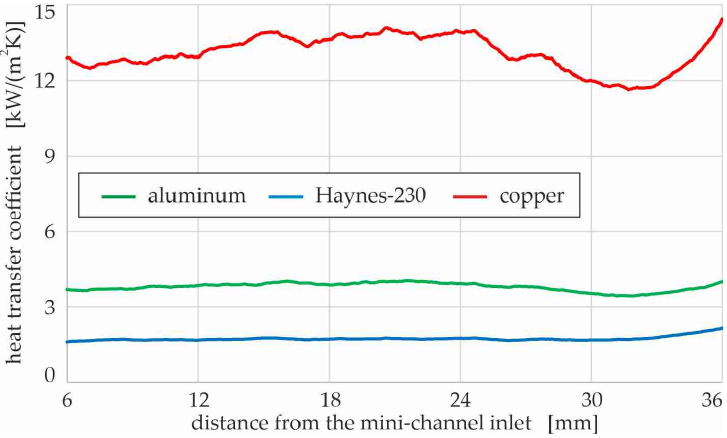
Figure 12. Heat transfer coefficient versus the distance from the mini-channel inlet, numerical simulations conducted in Simcenter STAR-CCM+ software assuming that the heater was made of: Haynes ‐ 230 alloy, aluminum, and copper .